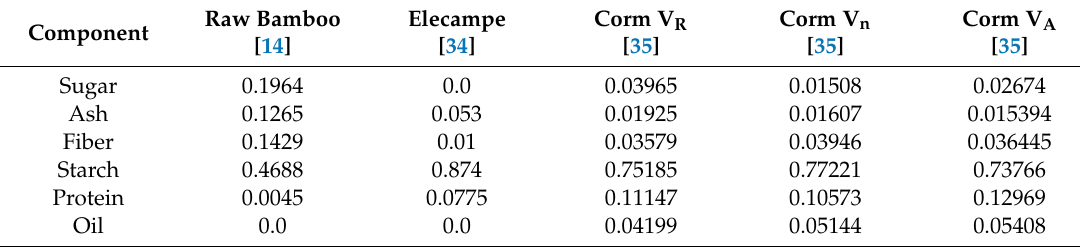
Table 6. Chemical composition of several agricultural products.